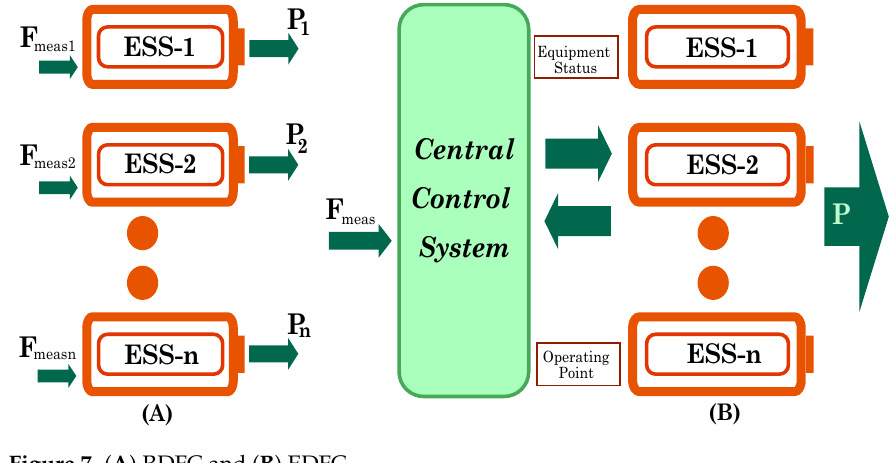
Figure 7. ( A ) RDFC and ( B ) EDFC.